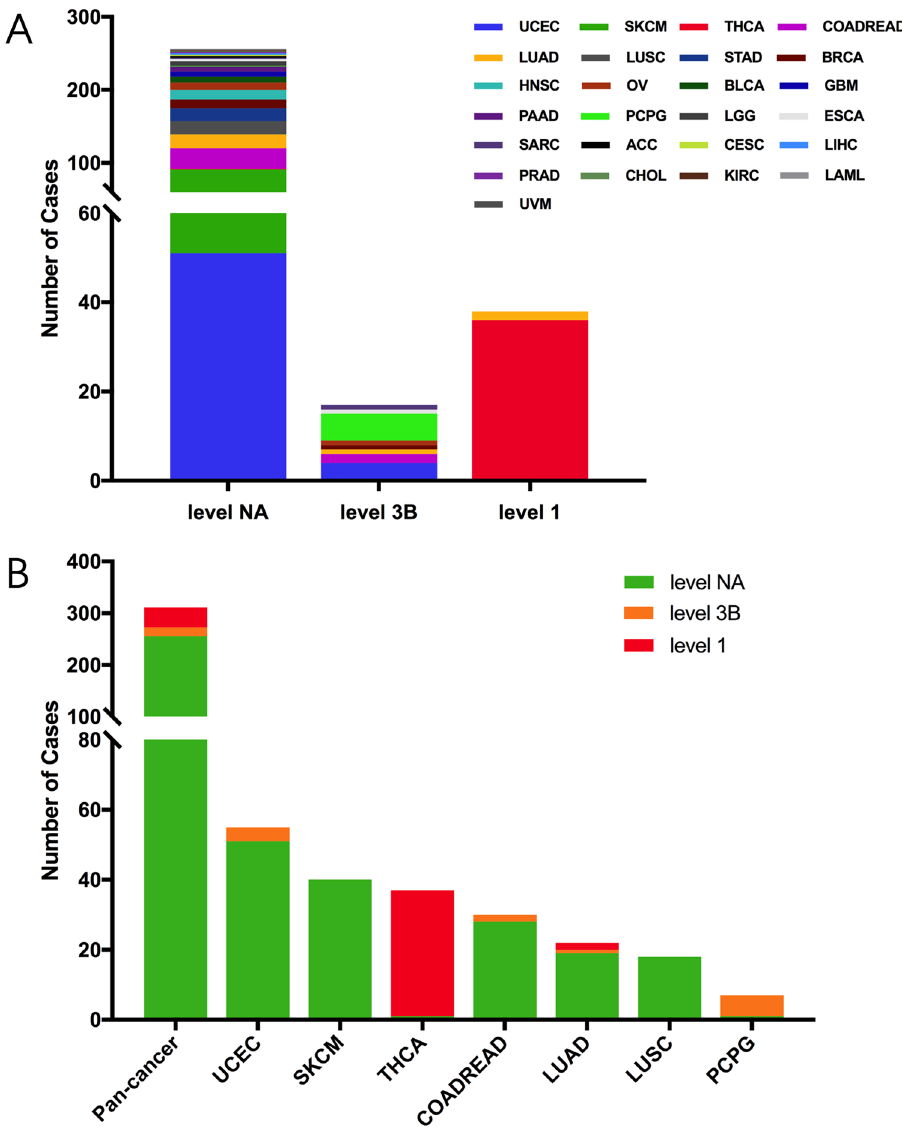
Figure 4. The classification of RET somatic mutation according to its therapeutic implications. ( A ) RET somatic mutation classification based on its therapeutic implications as annotated in OncoKB among diverse TCGA cancers. ( B ) Targeted therapy implications distribution of RET somatic mutations in pan cancer and the top 7 cancer